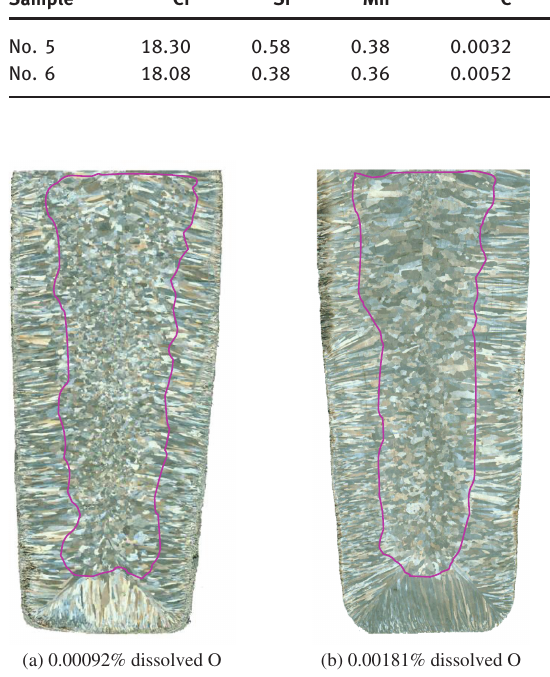
Figure 3: Solidificationstructureof steelwiththedifferentdissolvedO.